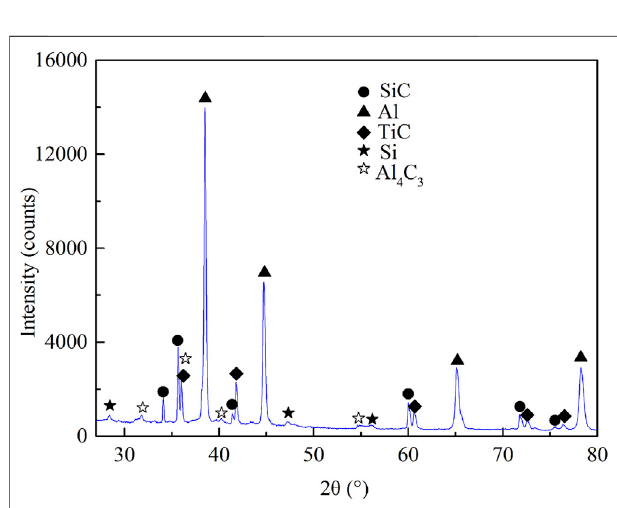
FIGURE 10 | XRD results of SiC p /6061Al laser welding with Ti